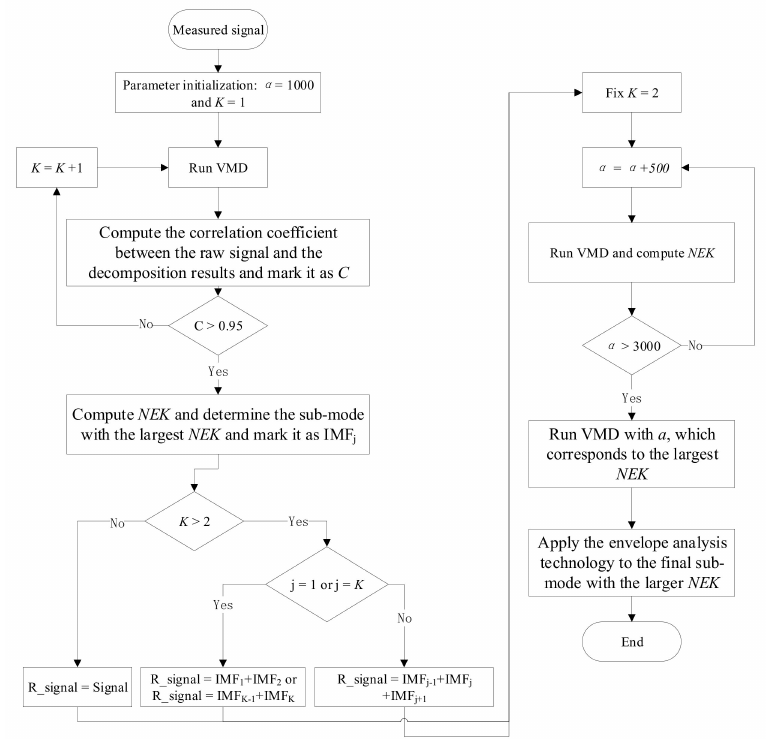
Figure 2. The flowchart of